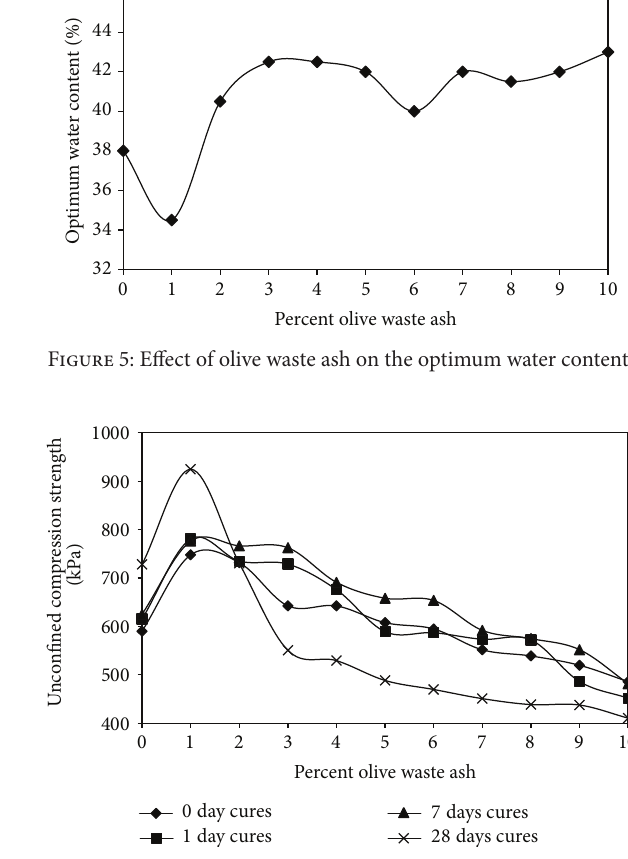
Figure 6: The effect of burned olive waste on the unconfined compressive strength of the treated